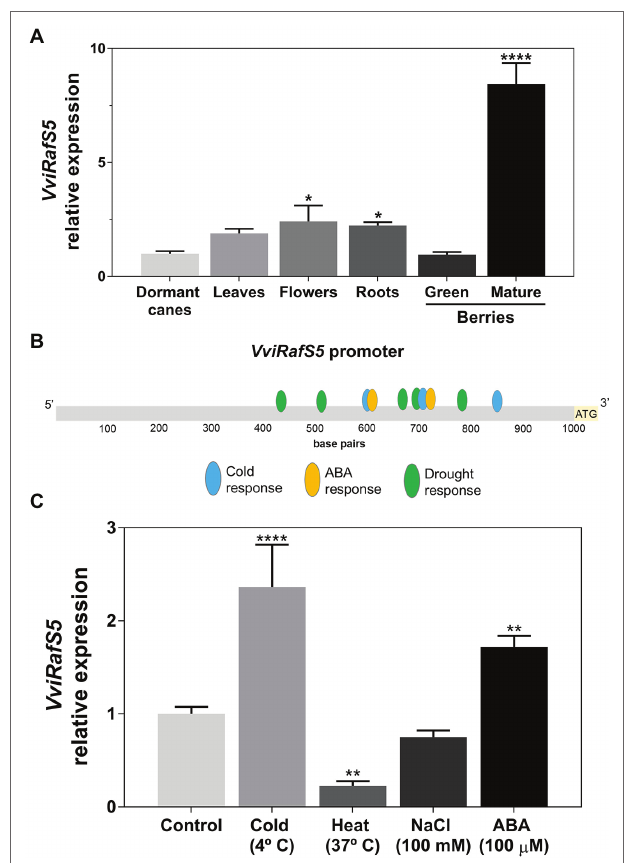
FIGURE 6 | Transcriptional regulation of VviRafS5 . Cis -regulatory elements found in the VviRafS5 promotor involved in stress response (A) . Transcriptional analysis of VviRafS5 in Gamay Fréaux cells after 24 h of cold (4 ° C), heat (37 ° C), and salt (100 mm) stresses and ABA (100 μ m) elicitation (B) . Transcriptional analysis of VviRafS5 in several organs from Vitis vinifera cv. Vinhão (C) . Results indicate the mean ± SD of three independent experiments. Statistical differences between mean values are marked with asterisks ( * p < .05; ** p < .01; **** p <